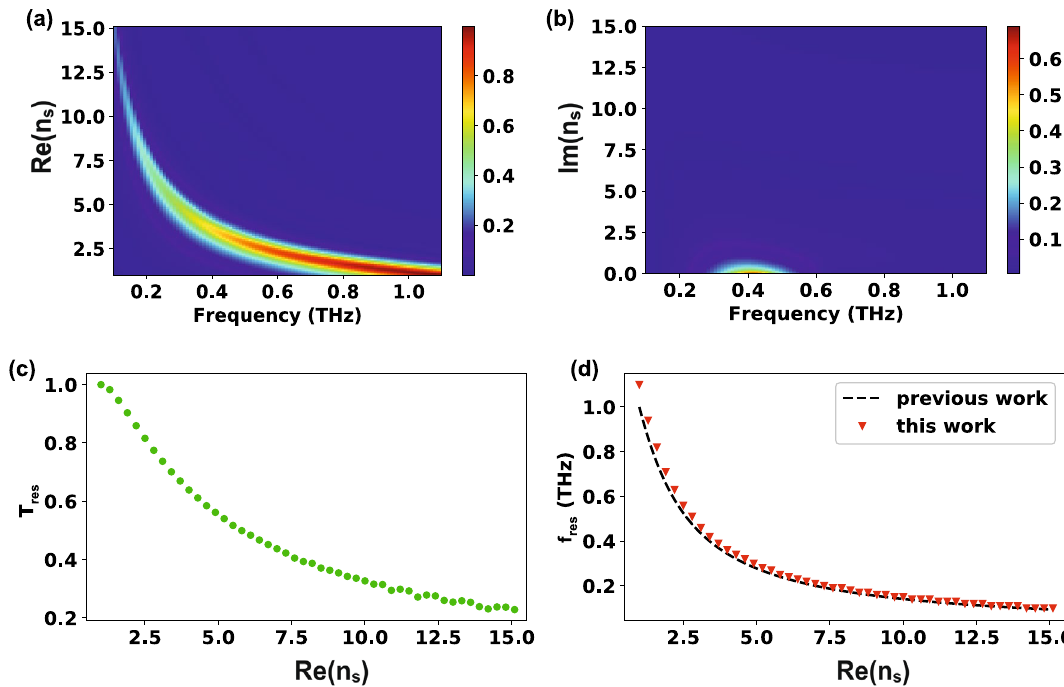
Figure 2. Transmission characteristics of three-layer system. The geometry of the slot antennas: w = 25 µ m, l = 150 µ m, h = 70nm, p x = 127 µ m, and p y = 180 µ m . ( a ) Transmission as functions of frequency and real part ( Re ( n s ) ) of refractive index of the substrate. ( b ) Transmission as functions of frequency and imaginary part ( Im ( n s ) ) of refractive index of the substrate. ( c ) Maximum transmission versus Re ( n s ) . ( d ) Resonance frequency versus Re ( n s ) . The downward triangles and dotted line represents the calculation results of the proposed model and previously reported equations (Eq. 1), respectively 14 .